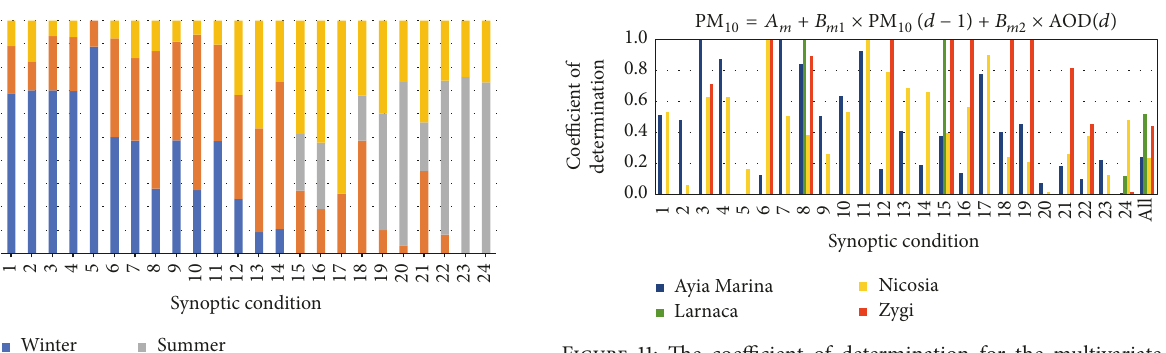
Figure 11: The coefficient of determination for the multivariate linear regression, for the Ayia Marina, Larnaca, Nicosia, and Zygi stations. It is shown separately for each of the synoptic conditions (1–24) and for all cases irrespective of the prevailing synoptic condition (shown as